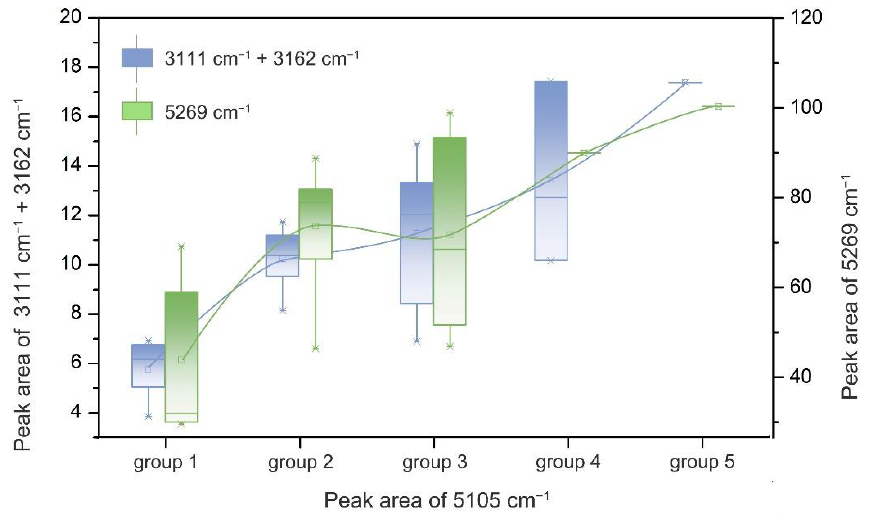
Figure 7. (1) The peak areas at 5105 cm −1 were positively correlated with the sum of peak areas at 3111 cm − 1 and 3162 cm − 1 , which are represented by blue boxes. The samples were divided into five 3111 cm −1 and 3162 cm −1 , which are represented by blue boxes. The samples were divided into five groups by K-means clustering. (2) The peak areas at 5105 cm − 1 were positively correlated with the groups by K-means clustering. (2) The peak areas at 5105 cm −1 were positively correlated with the peak areas at 5269 cm − 1 , which are represented by green boxes. The samples were divided into five peak areas at 5269 cm −1 , which are represented by green boxes. The samples were divided into five groups by K-means groups by K-means clustering.